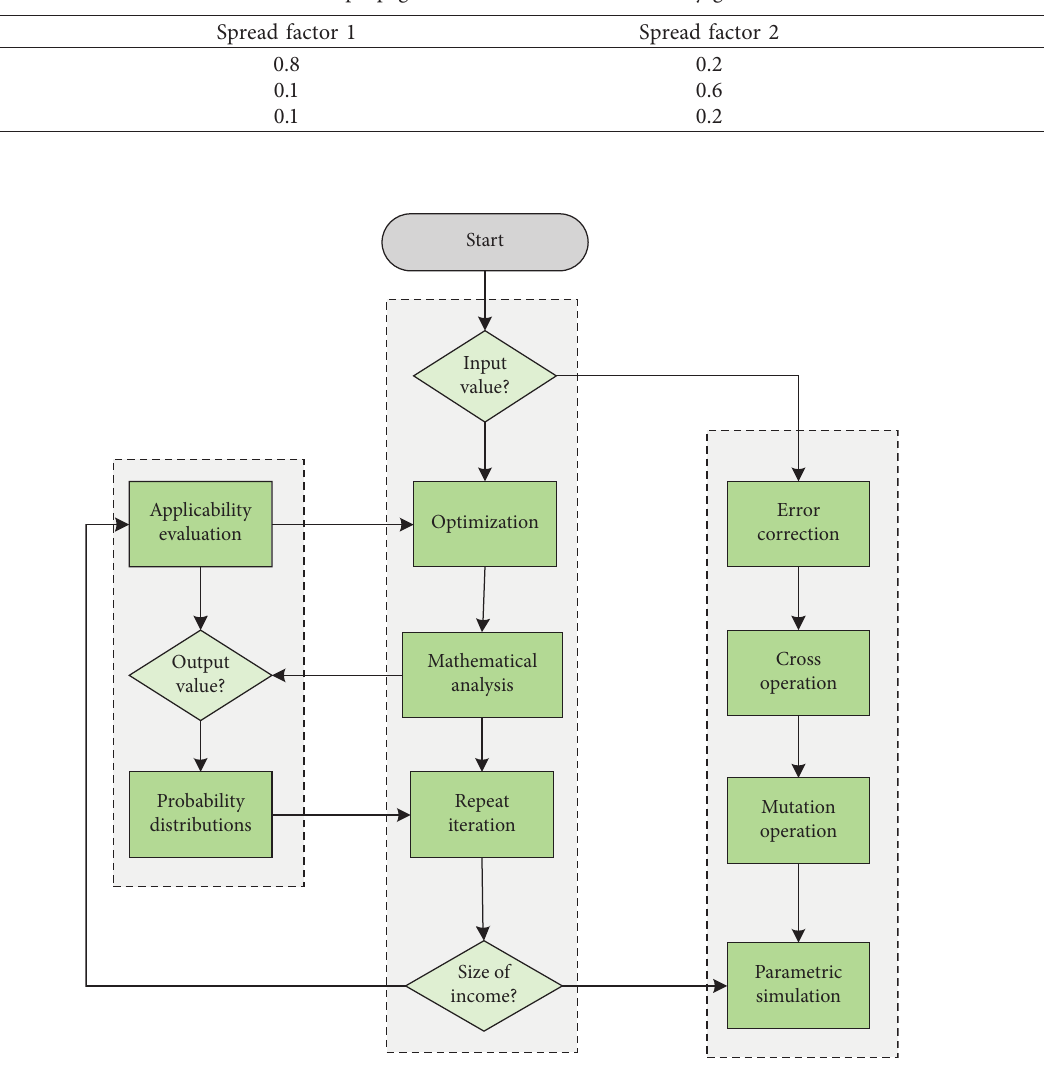
Table 2: The propagation matrix of the evolutionary game.